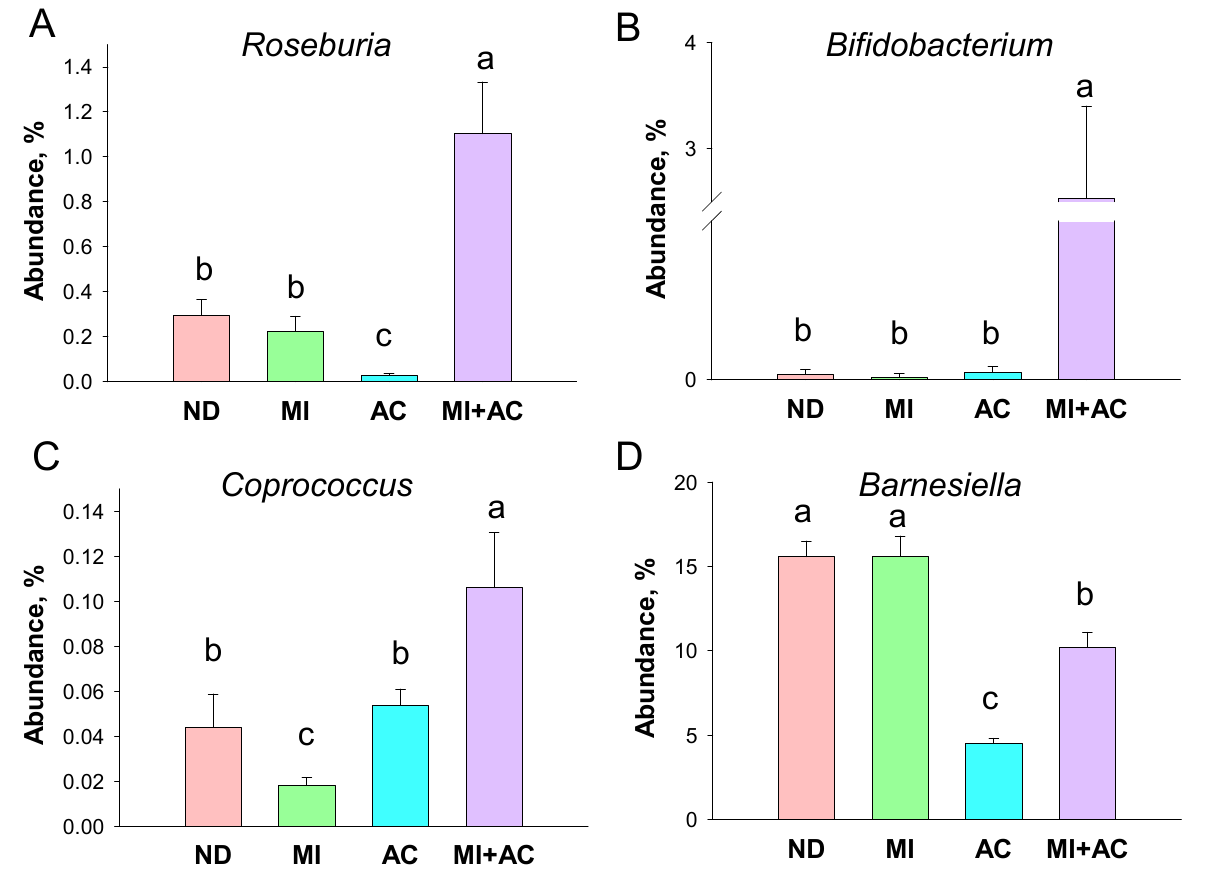
Figure 5. Effect of minocycline administration (MI) and acetate supplementation (AC) on the gut microbiota in 12-week-old male progeny: genus level relative abundance of ( A ) Roseburia , ( B ) Bifi- dobacterium , ( C ) Coprococcus , and ( D ) Barnesiella ( n = 7–8/group). The letters a, b, and c above the bars denote significant differences between groups ( p < 0.05, one-way ANOVA). ND = rats received vehicle (control); MI = rats received minocycline; AC = rats received acetate; MI + AC = rats re-ceived minocycline and acetate